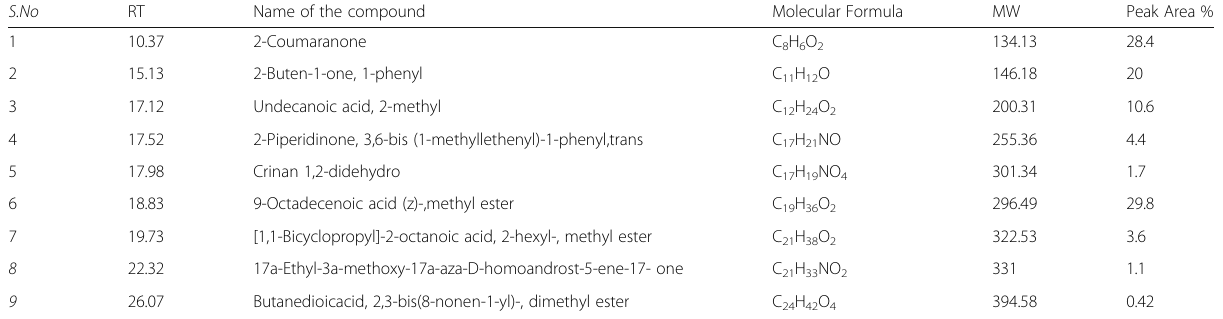
Table 2 List of major phytoconstituents identified in the methanolic extract of AR (rhizome) by GC-MS